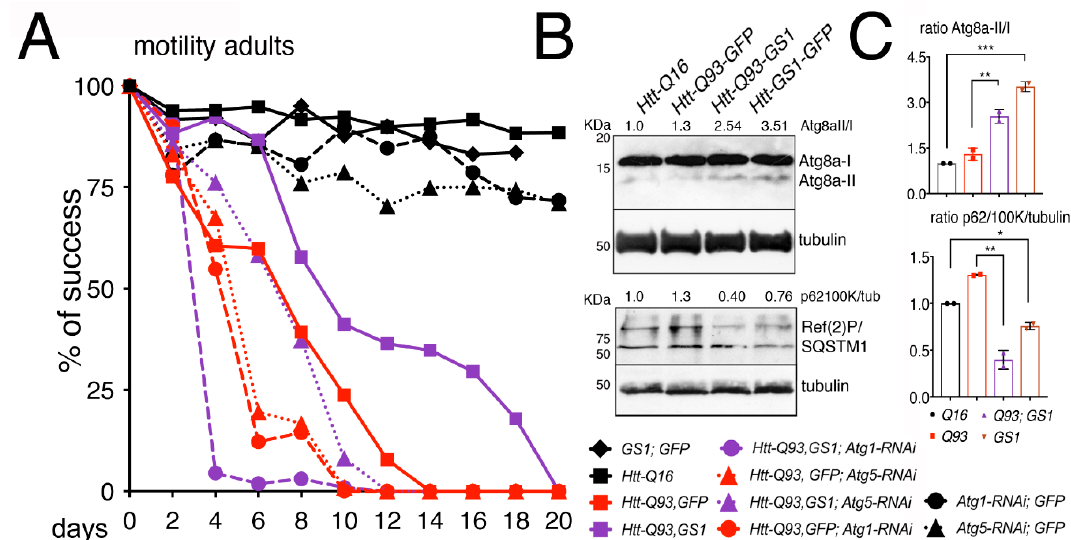
Figure 5. Reduction of Atg1 and Atg5 significantly impairs the ability of GS1 to rescue the motility defects induced by Htt-Q93 . ( A ) 15 adult females were used for each genotype and their % of success in motility reported in the graph, the p -values from the one-way ANOVA are reported in the Excel file 1. ( B ) The presence of GS1 favors Atg8a cleavage and reduces the presence of Ref(2)P. Western blots from heads of females at 10 DAE of the indicated genotype, showing the pattern of expression of Atg8a-I and II and of SQSTM1 / Ref(2)P, note that in Drosophila the latter runs in two isoforms of about 100 and 62 KDa, both recognized by the Drosophila antibody. Tubulin was used as the control for loading. Experiments were repeated at least twice with similar results. 10 heads were used for each genotype. ( C ) The ratio for Atg8a-II / I and Ref(2)P / tubulin were calculated by comparing the quantification of the relative proteins with ImageJ to that in control Htt-Q16 animals, previously normalized to tubulin. We calculate the ratio using the 100 KDa isoform, since it is described as the ortholog of human p62 [41]. One-way ANOVA p -values: *** p < 0.001, ** p < 0.01, * p < 0.05 were calculated from two independent experiments of animals, and error bars indicate the standard deviations.